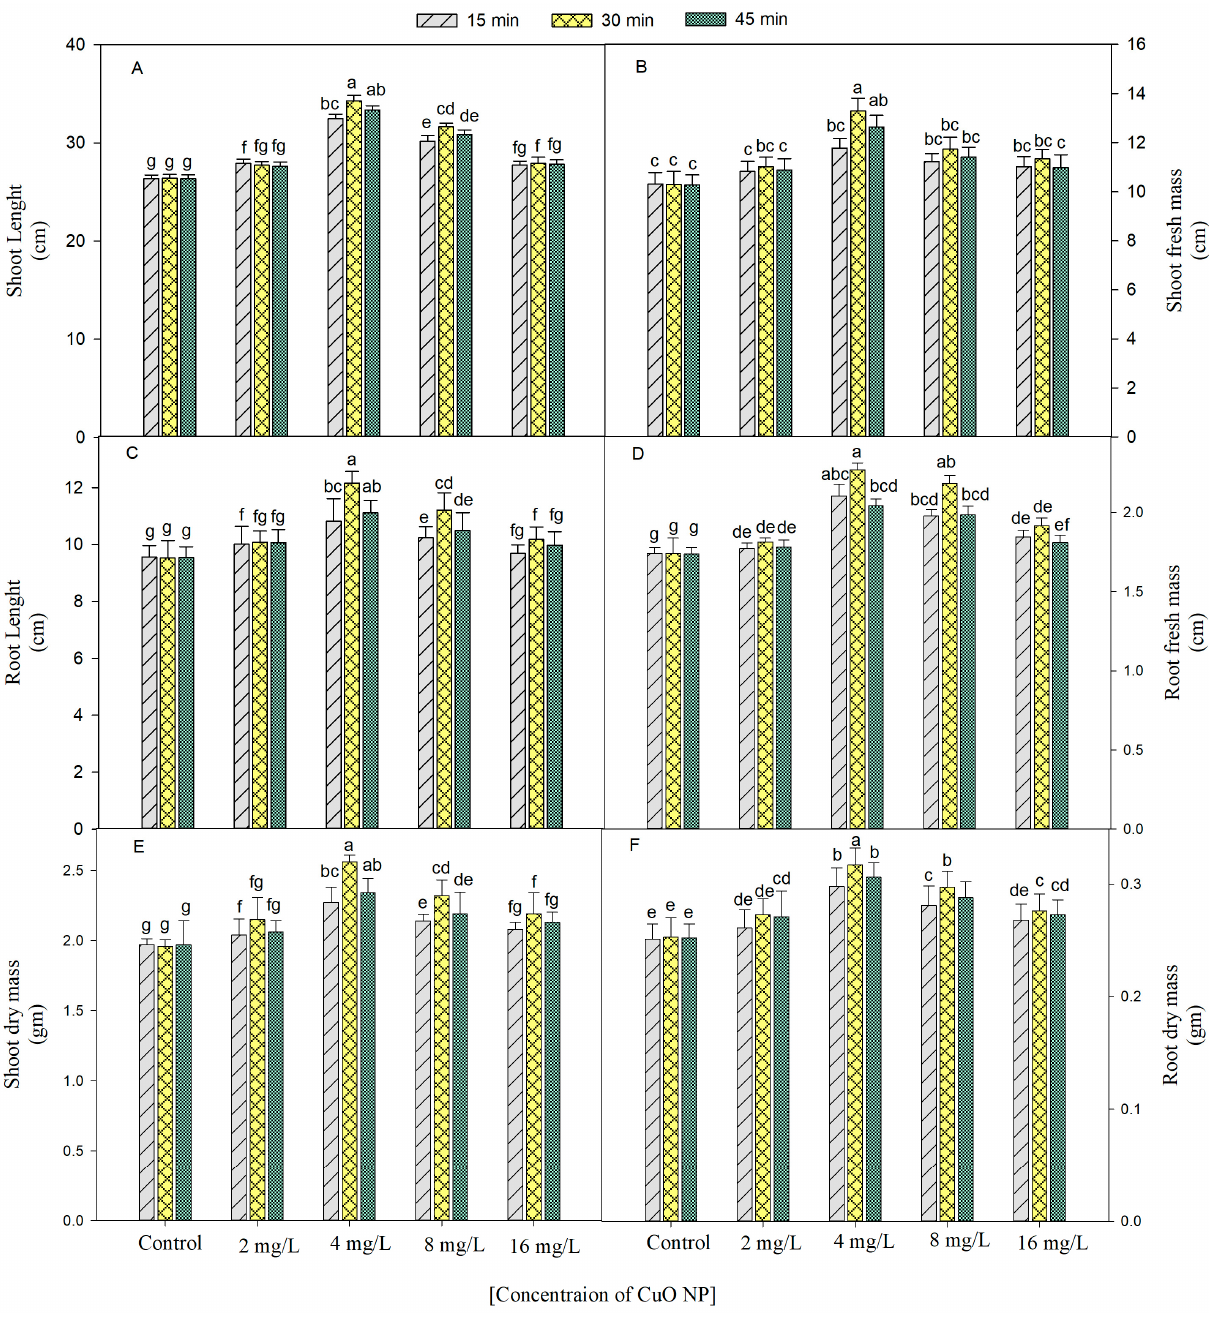
Figure 1. Outcome of CuO NPs on shoot ( A ) and root ( C ) lengths, fresh biomass of shoot ( B ) and root ( D ), and dry biomass of shoot ( E ) and root ( F ) of Brassica juncea at 45 DAS. All the data represent the mean of five replicates ( n = 5); significant differences between control and treatment and among treatments were represented by different letters and standard error ( ± SE) was represented by vertical bars.